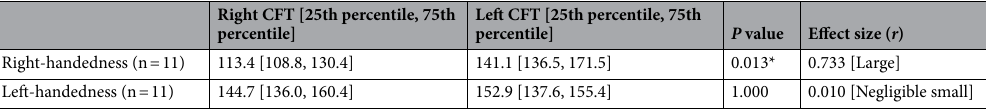
Table 1. Median differences in signal intensity of right and left CFT in each handedness. * P < 0.05.